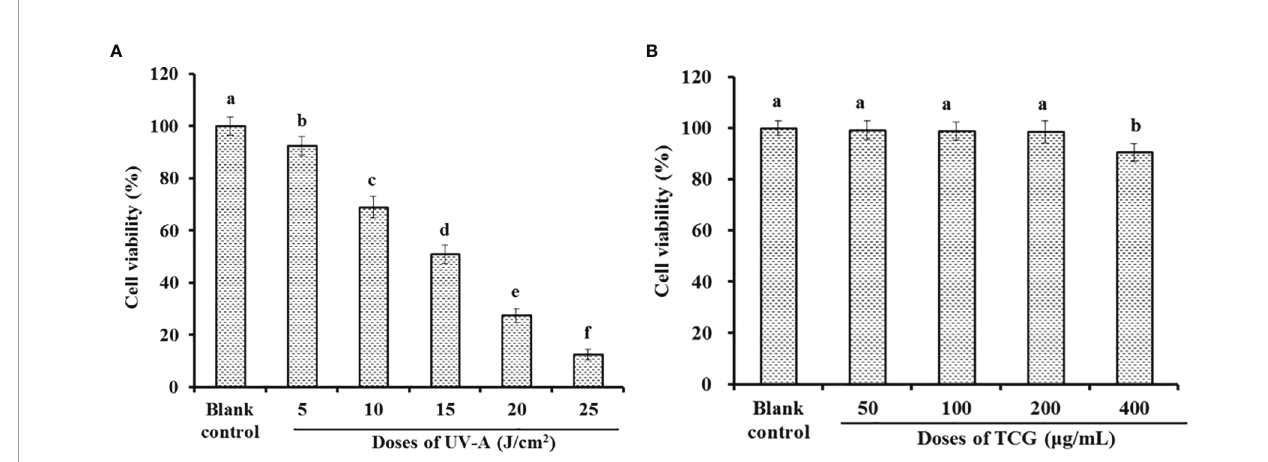
FIGURE 6 | Effects of ultraviolet-A radiation (A) and cartilage gelatin (B) doses on the viability of human skin fi broblasts. All data are presented as the mean ± SD ( n = 3). Values with the same letters indicate no signi fi cant difference ( P > 0.05).